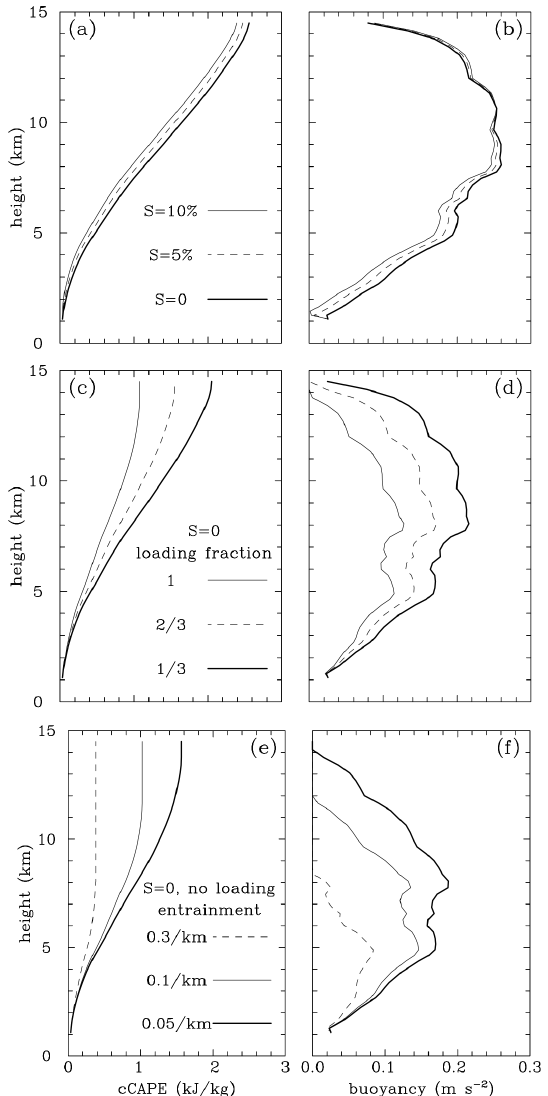
Figure 3. Profiles of (a, c, e) cumulative CAPE (cCAPE) and (b, d, f) buoyancy from parcel analysis using mean temperature and hu- midity profiles from the lowest 500m of 2MOM PRIS simulation averaged over the 6th and 7th hours. (a, b) Pseudo-adiabatic parcel calculations with different supersaturations. (c, d) Parcel calcula- tions with different fractions of the condensate included in parcel buoyancy. (e,f) Entraining parcel calculations with different frac- tional entrainment